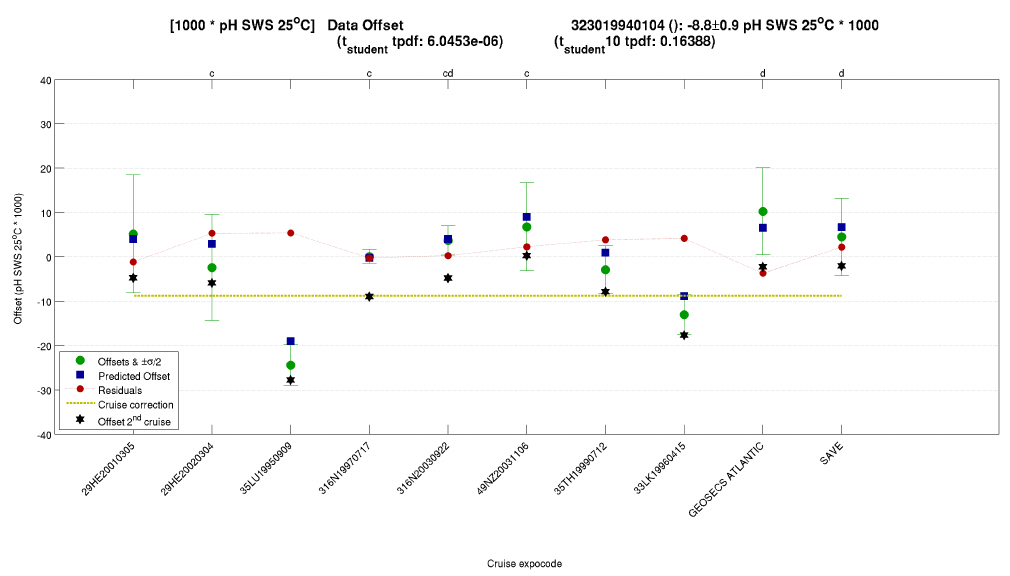
Figure 24. Cruise crossover information plot for